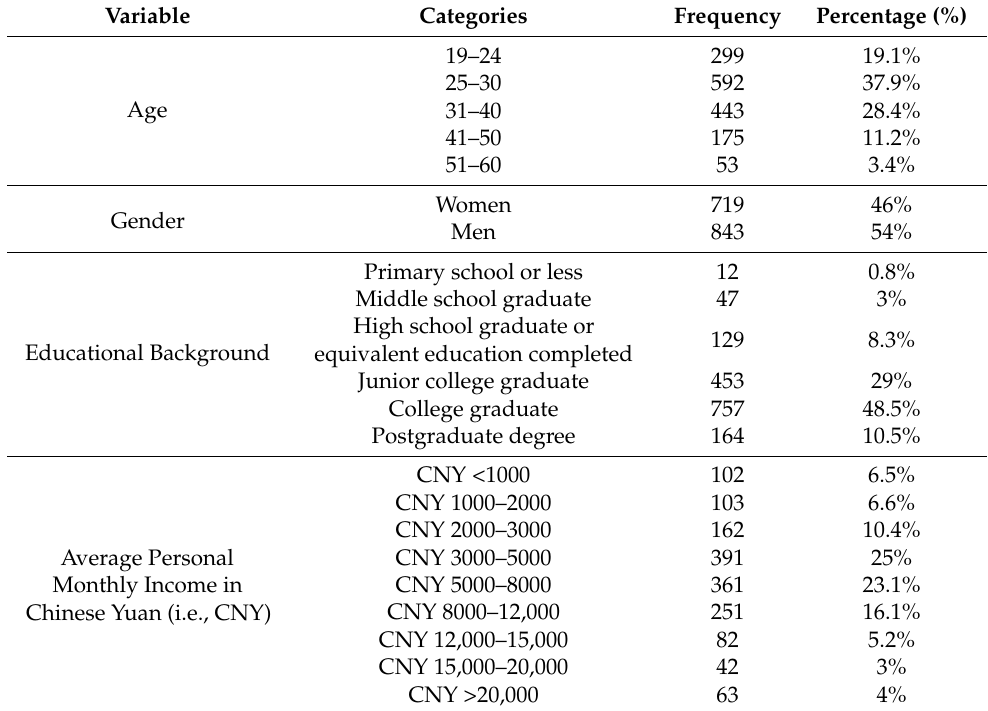
Table 1. Demographic characteristics of study participants ( N =